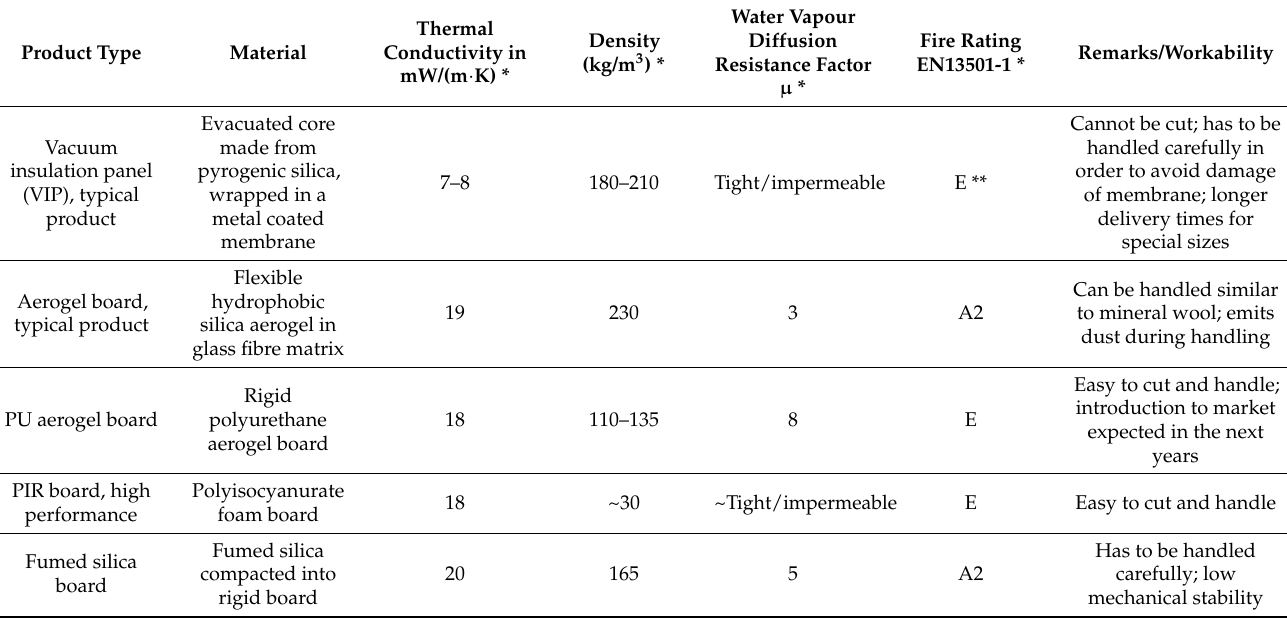
Table 1. Materials for screening for the application as thermal insulation in trains with selected